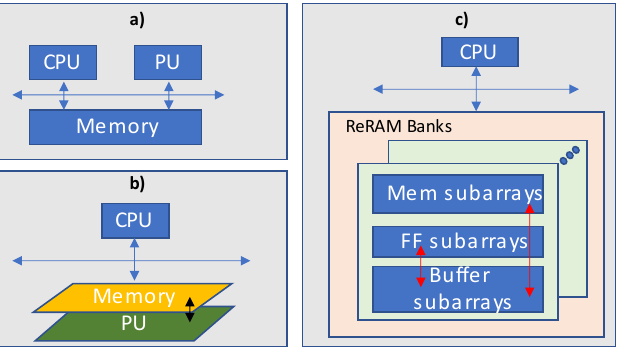
Figure 18. An overview of the ( a ) traditional shared memory, ( b ) 3D PIM, and ( c ) PRIME [21]. ReRAM and crossbar networks based on it, have immense ability for graph processing.